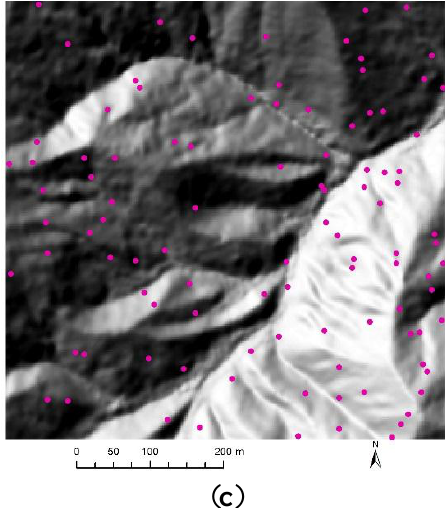
Figure 4. Distribution of the 100 critical points selected by ( a ) TPS-based algorithm, ( b ) max-Z and ( c ) the random method in the hilly terrain.